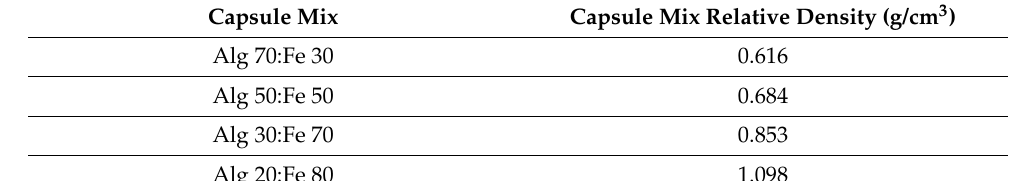
Table 2. Capsule relative density.